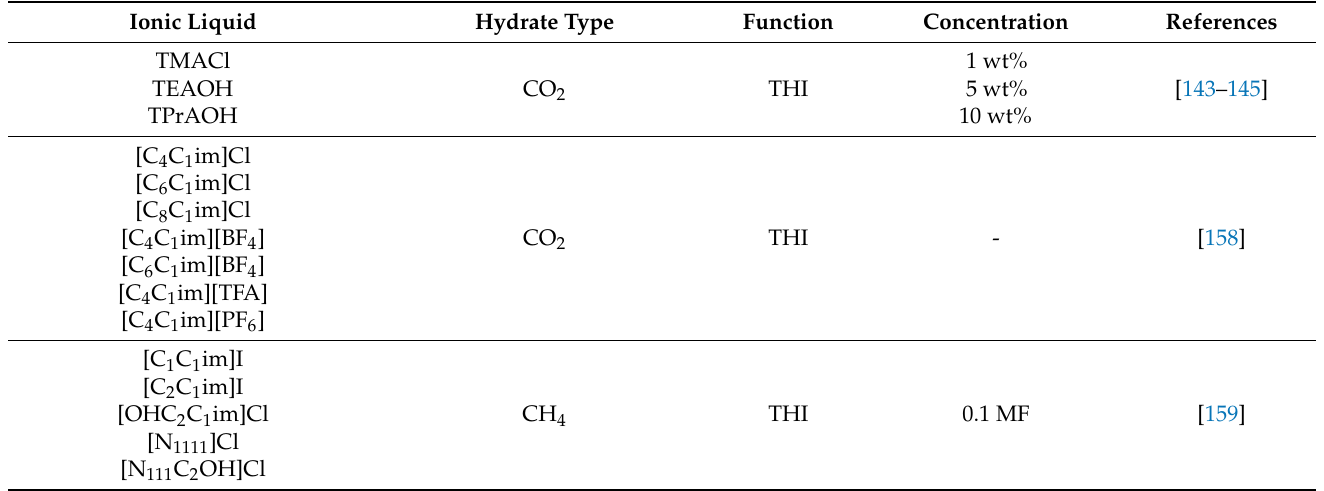
Table 8. Summary of ionic liquids used as THIs in oil/gas